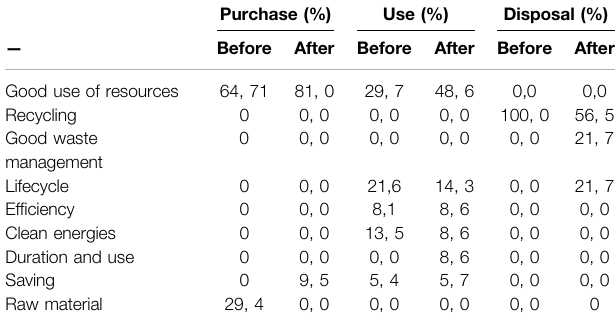
TABLE 3 | Description of the concepts associated with Consumption